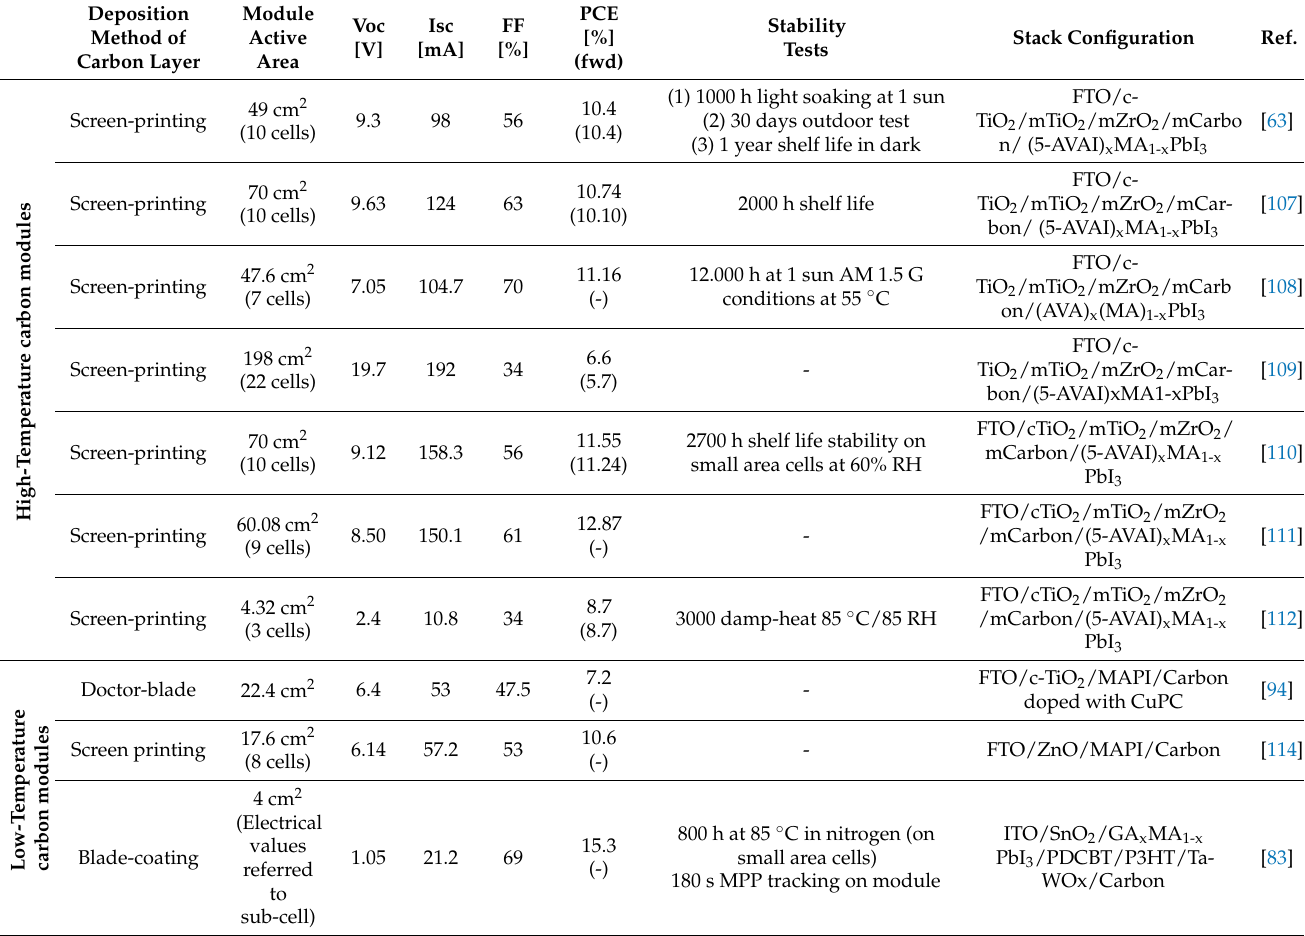
Table 1. Reported deposition technique of carbon electrode, photovoltaic parameters, stability tests, and device stack configuration on perovskite solar module with high- and low-temperature carbon